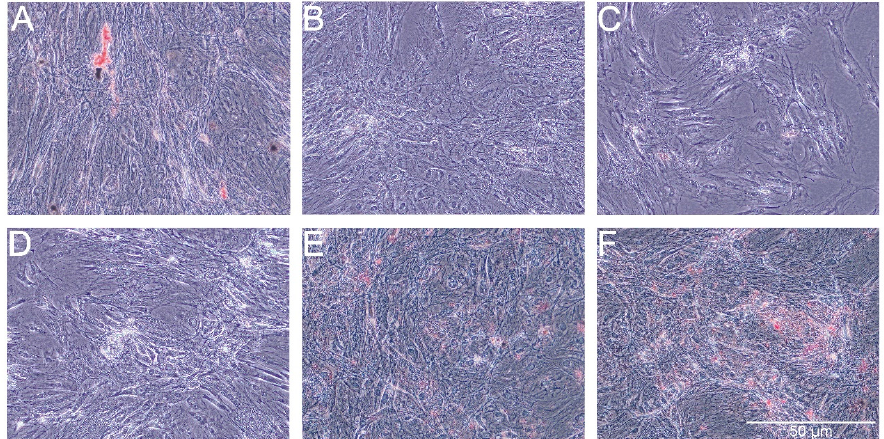
Figure 7. Oil red staining of lipid droplets after exposure of adipose-derived stem cells (ADSC) to the tested combinations of antibiotics. ADSC were exposed for 14 days to AmB ( B ), AmB-Cu 2+ ( C ), PS ( D ), PS-AmB ( E ) and PS-AmB-Cu 2+ ( F ), and compared to the control cells ( A ).